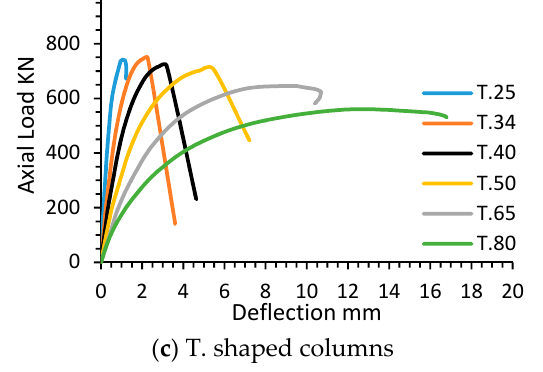
Figure 8. Influence of increased slenderness ratio (SR) on load-deflection curves of specimens.